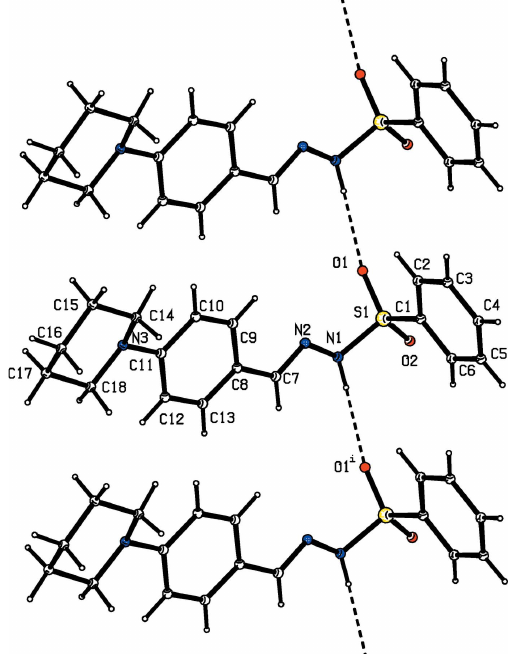
Figure 4 Hydrogen-bonding pattern in (I) with hydrogen bonds shown as dashed lines. Symmetry code as in Table 1.